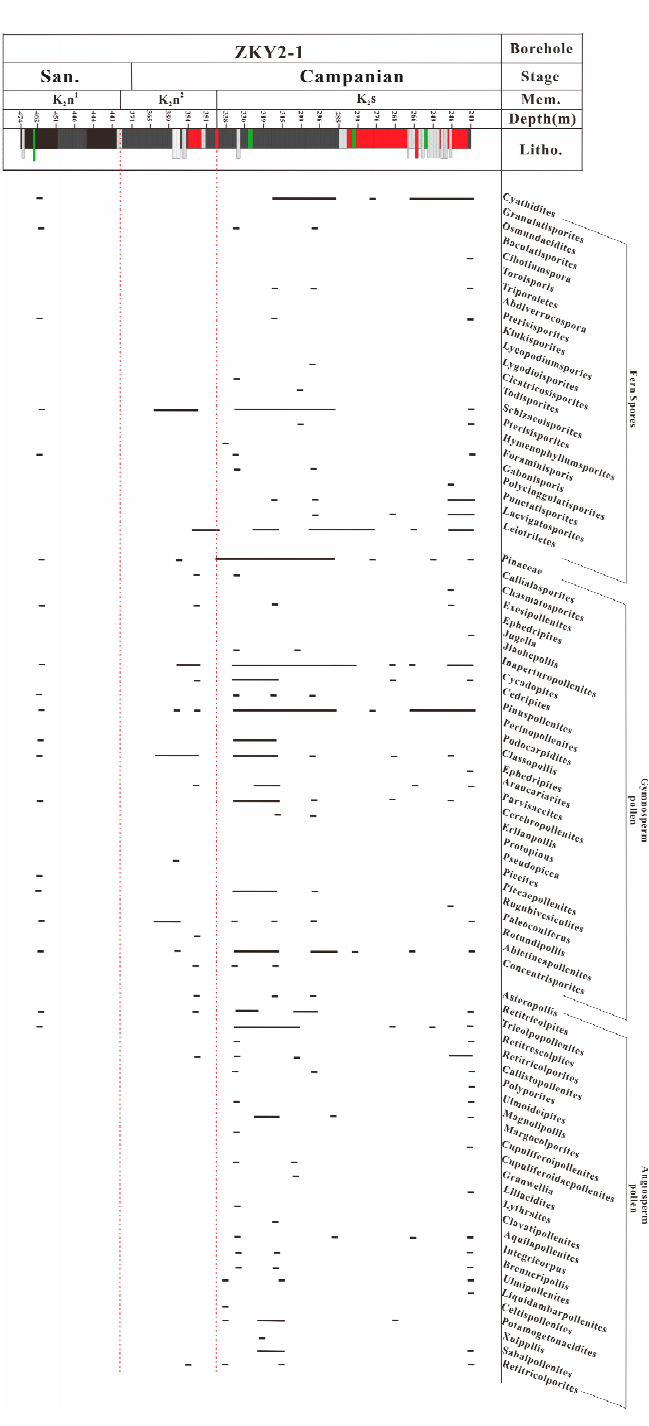
Figure 3. Distribution of the palynomorphs from K 2 n 1+2 to K 2 s in borehole ZKY2-1.